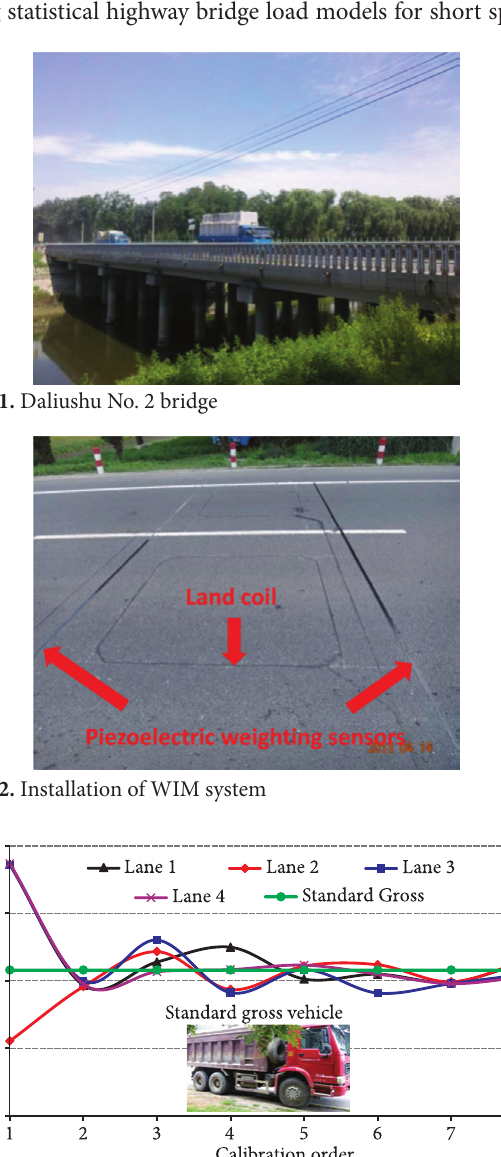
Fig. 3. Calibration curves of each